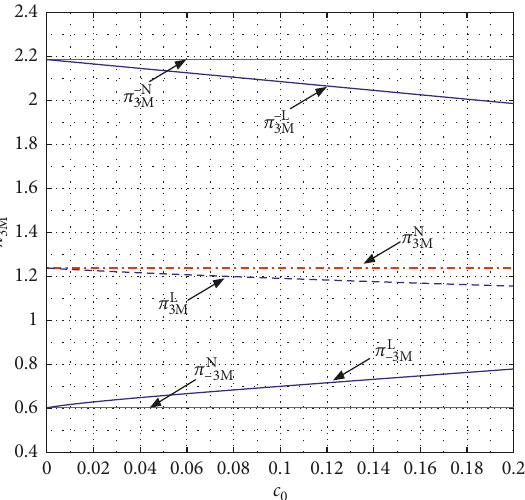
and π : (a) supplier’s profits; (b) enlarged image of inset in (a). 0 1M